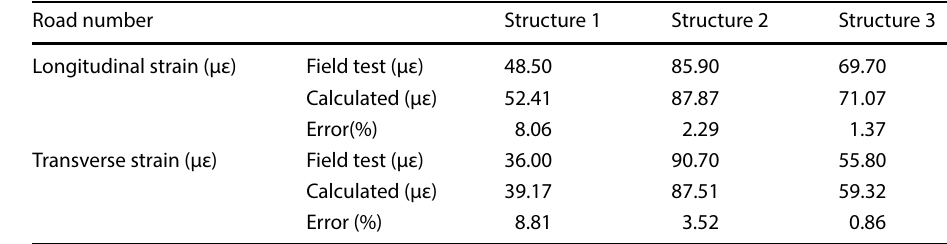
Table 2 The maximum strain in the field test